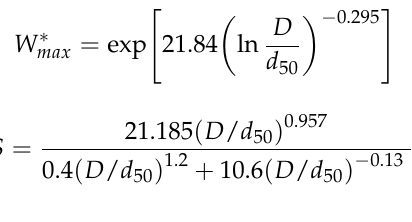
Equation (25). Data source: Sheppard et al. [9].